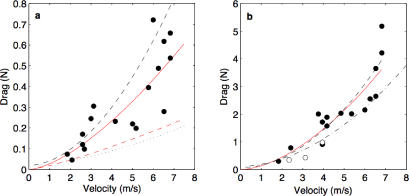
Drag Measurements and Model Predictions(A) Drag measurements for a resin cast of a Rynchops niger cinerascens mandible. Solid red line is an OLS of log-transformed data, broken red line is the lower 75% confidence interval for the OLS. Broken black lines are drag estimates from fluid-dynamic models (dashed: aerofoil; dotted: thin plate approximation).(B) Drag measurements for Tupuxuara sp. mandible model (filled circles), and that of a mandible attributed to Thalassodromeus (open circles). The solid line is a OLS for log-transformed Tupuxuara data, dashed line the drag estimate from fluid-dynamic models (aerofoil).